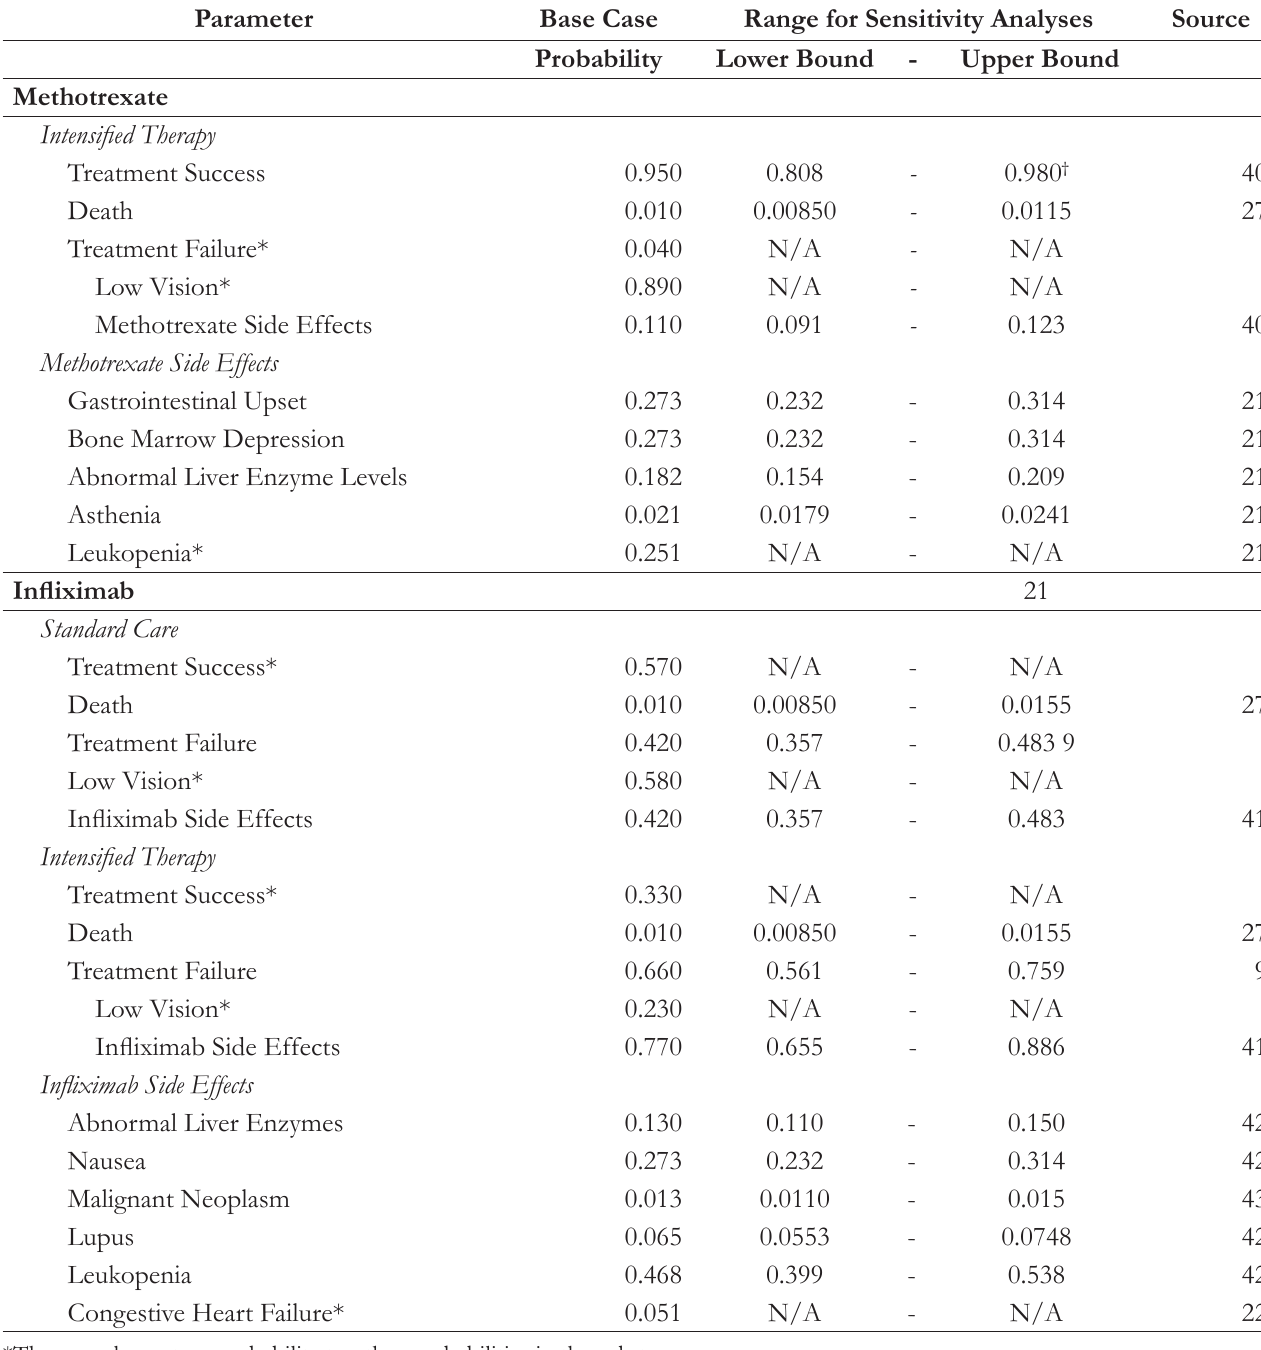
Table 1b. Probabilities and Transition Probabilities - Continued Parameter Base Case Range for Sensitivity Analyses Source Probability Lower